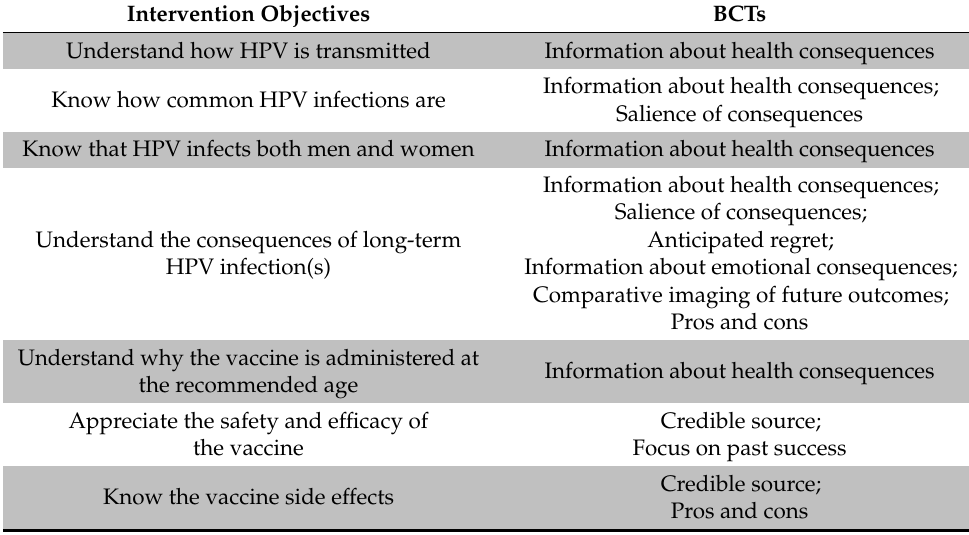
Table 3. Intervention objectives and associated Behaviour Change Techniques